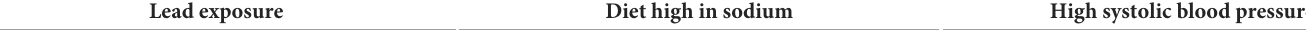
TABLE 7 Attributable risks of ASDALYR in